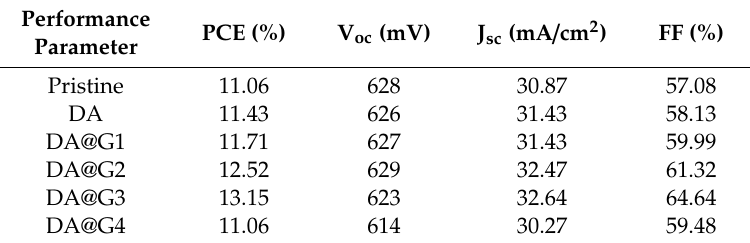
Figure 4. Current density–voltage (J–V) curves of prepared solar cells with different G concentration: ( a ) under illumination of AM 1.5 G light and ( b ) under dark condition. Table 1. Performance parameters of the most optimal solar cell.